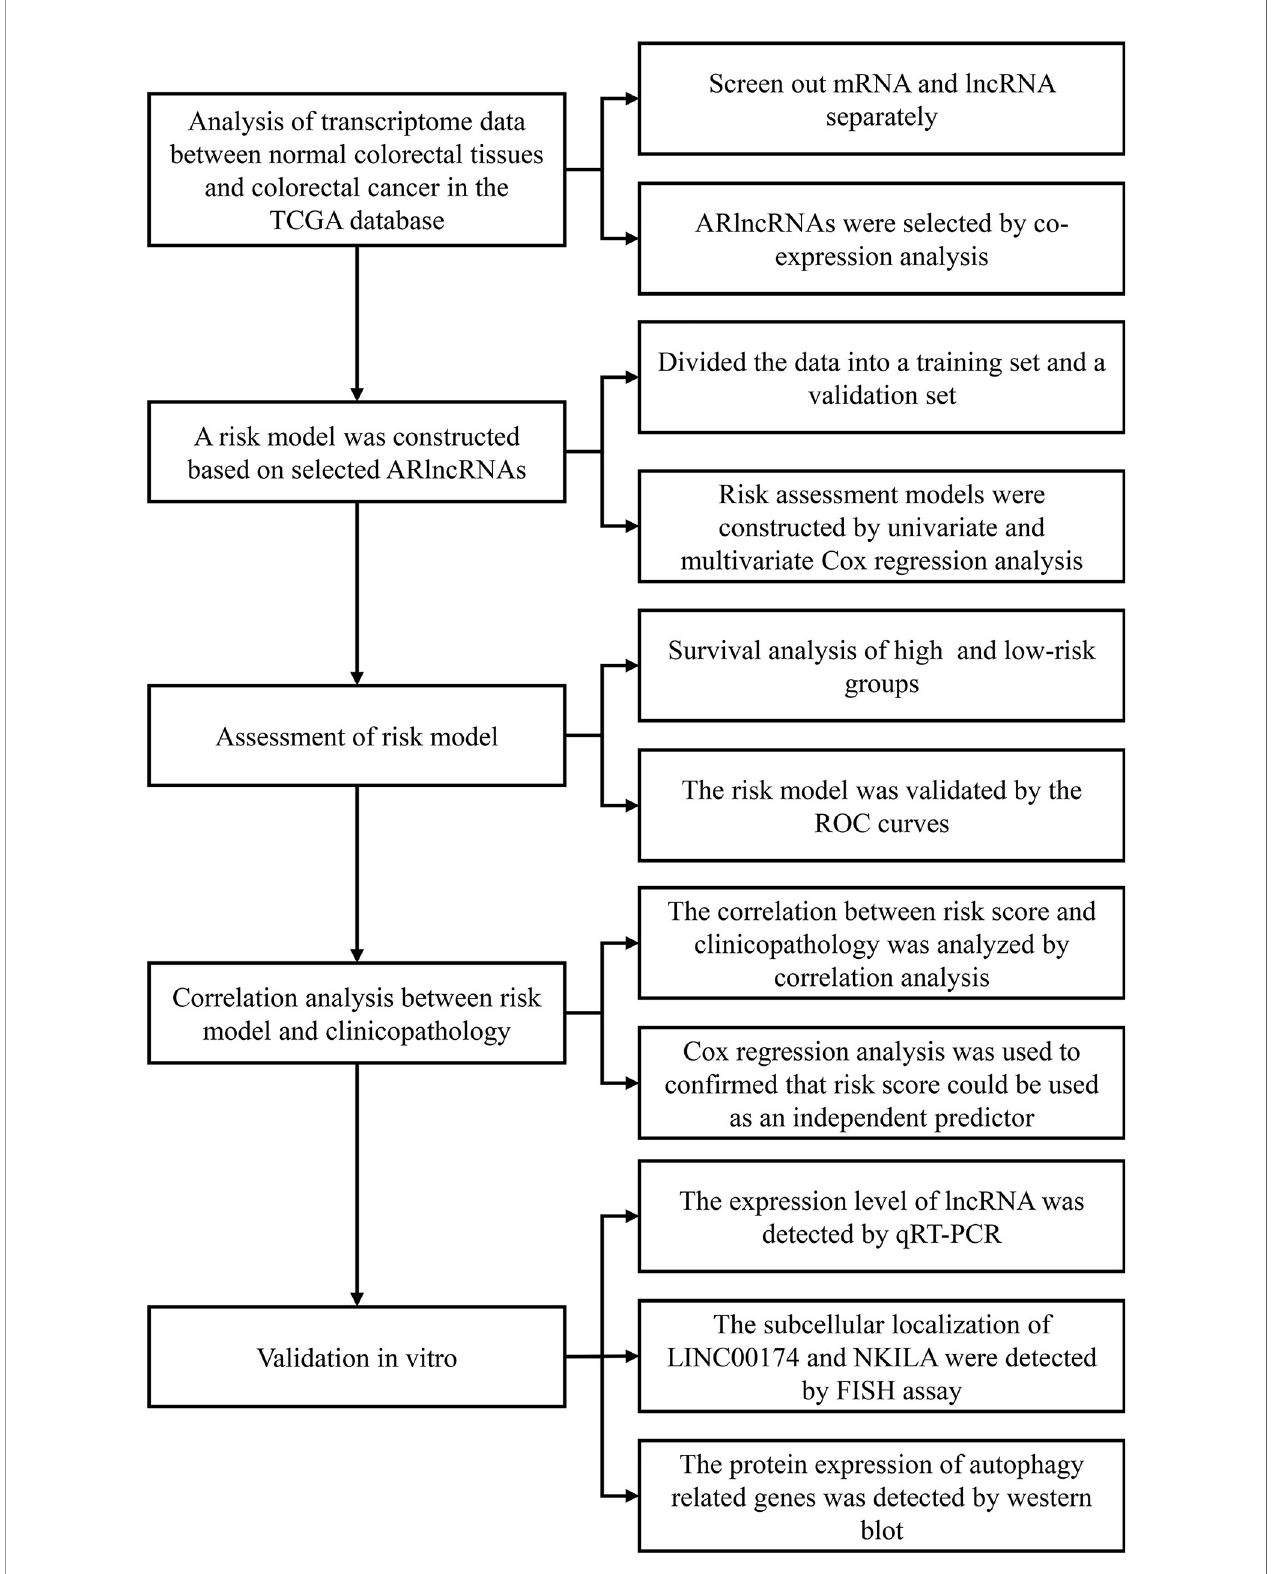
FIGURE 1 | The fl ow chart of overall procedures. TGCA, the Cancer Genome Atlas; IncRNA, long non-coding RNA; ARIcRNAs, autophagy-related IncRNAs; ROC, receiver operating characteristic; qRT-PCR, quantitative real-time polymerase chain reaction; FISH, fl uorescence in situ hybirdization.